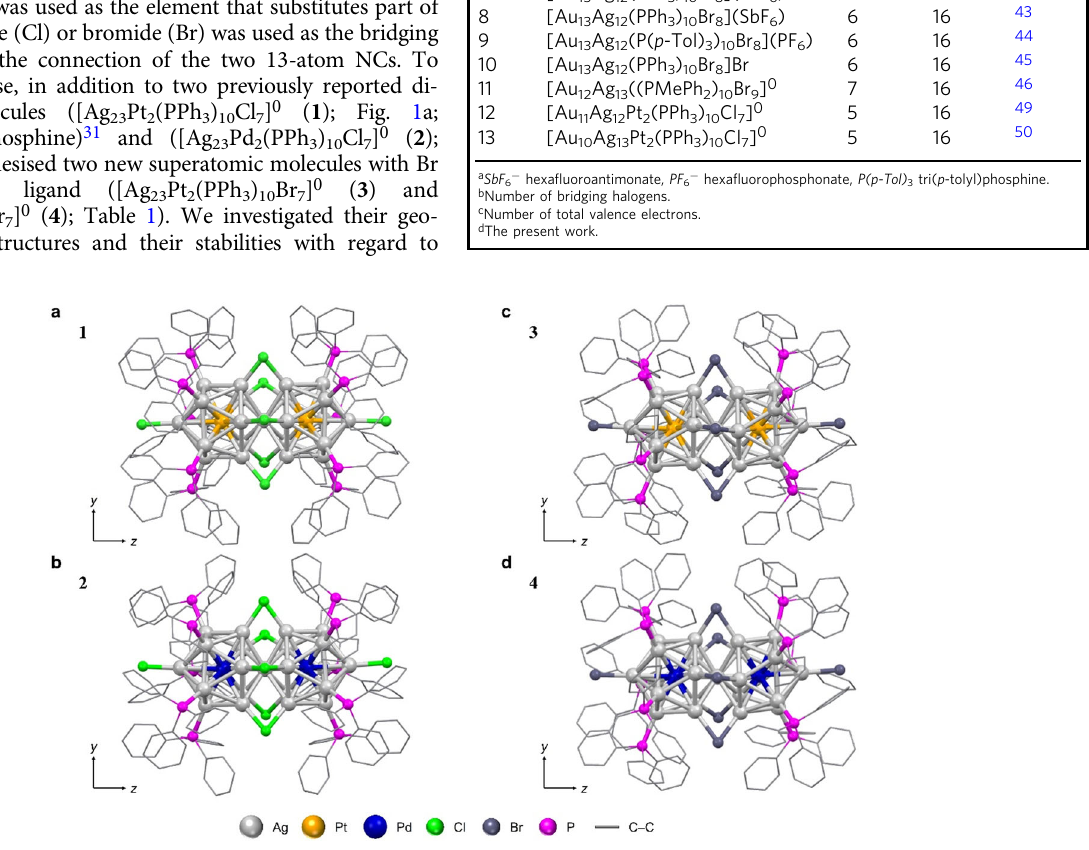
Fig. 1 Comparison of the geometric structures. a 1 . b 2 . c 3 . d 4 . The geometric structure of 1 and 2 are reproduced from ref. 28,31 , respectively (grey = Ag; orange = Pt; blue = Pd; green = Cl; dark grey = Br; magenta = P). The positions of the Pd atoms are the predicted positions based on DFT